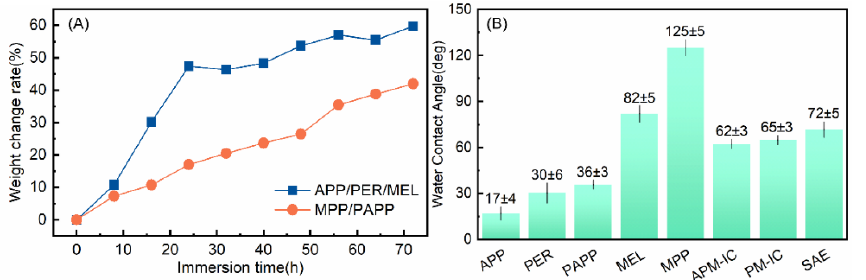
Figure 3. ( A ) The weight change of the coatings immersed in distilled water. ( B ) Water contact angle of IFR and ICs. of IFR and